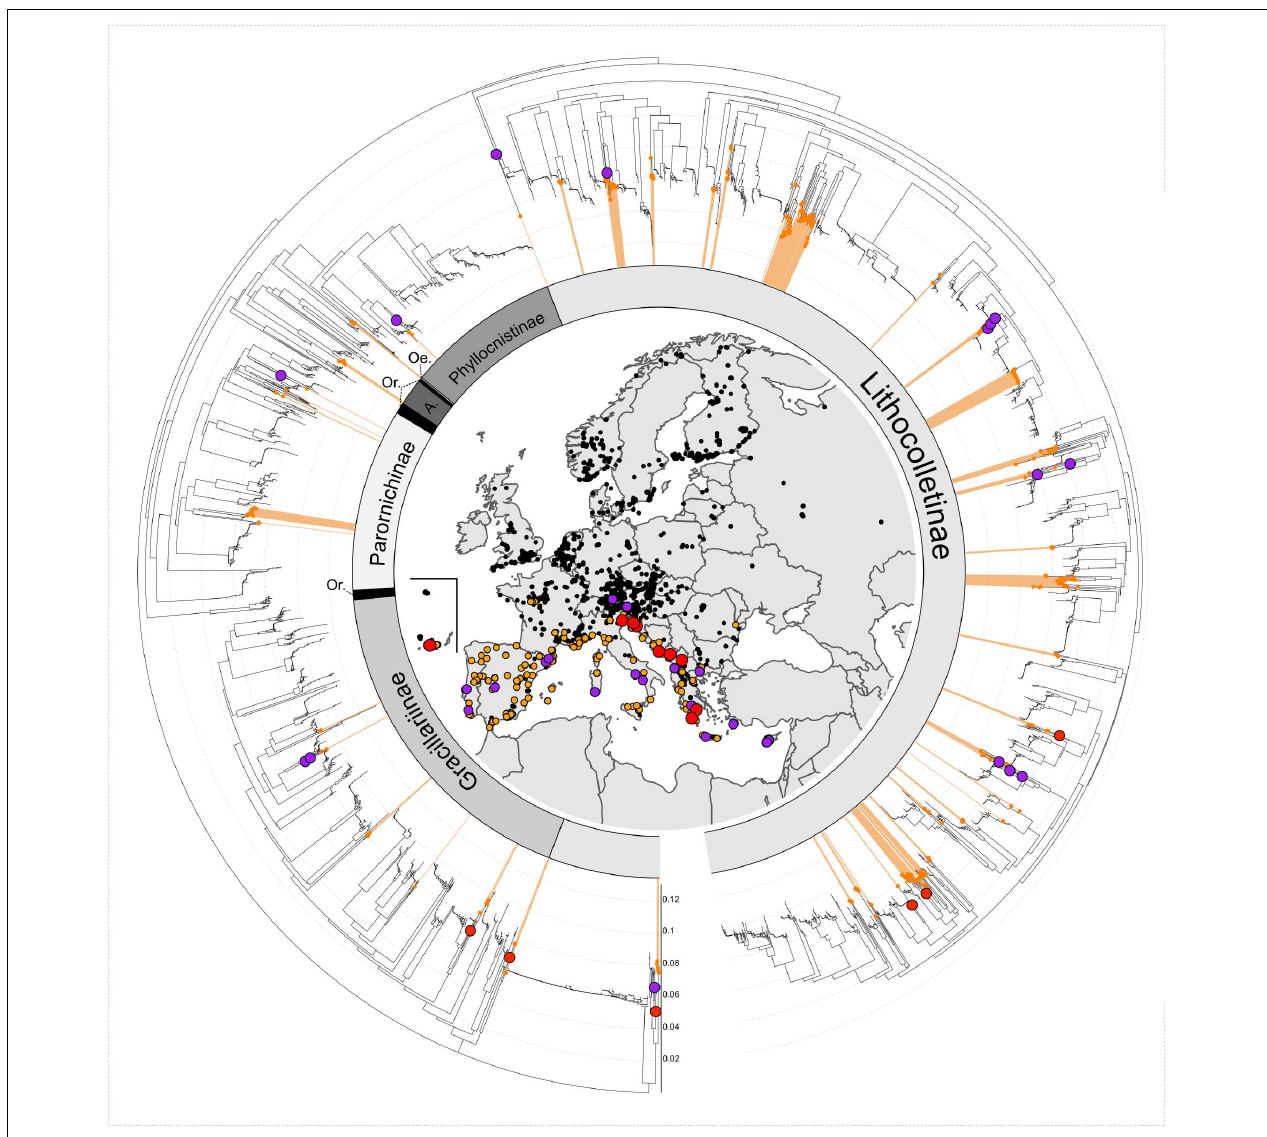
FIGURE 4 | DNA barcode variation in European Gracillariidae and geographical distribution of new candidate species. Neighbor-joining tree based on uncorrected p-distances for 5,148 records of the DNA barcode library of European Gracillariidae (1,643 records of Cameraria ohridella were removed to avoid topology distortion). The map shows all 6,791 georeferenced DNA barcode records for 242 named species and 21 new candidate species of European gracillariids. Colored circles represent individual records (map) or clusters (tree): in red six Confirmed Candidate Species (CCS); in purple 15 Unconfirmed Candidate Species (UCS); in orange 80 out of the 83 Mediterranean species sampled (three species, C. ohridella , Phyllonorycter platani , and P. leucographella were not colored on the map because they have undergone massive range expansion over most of Europe). Inner circle indicates the seven subfamilies of Gracillariidae found in Europe